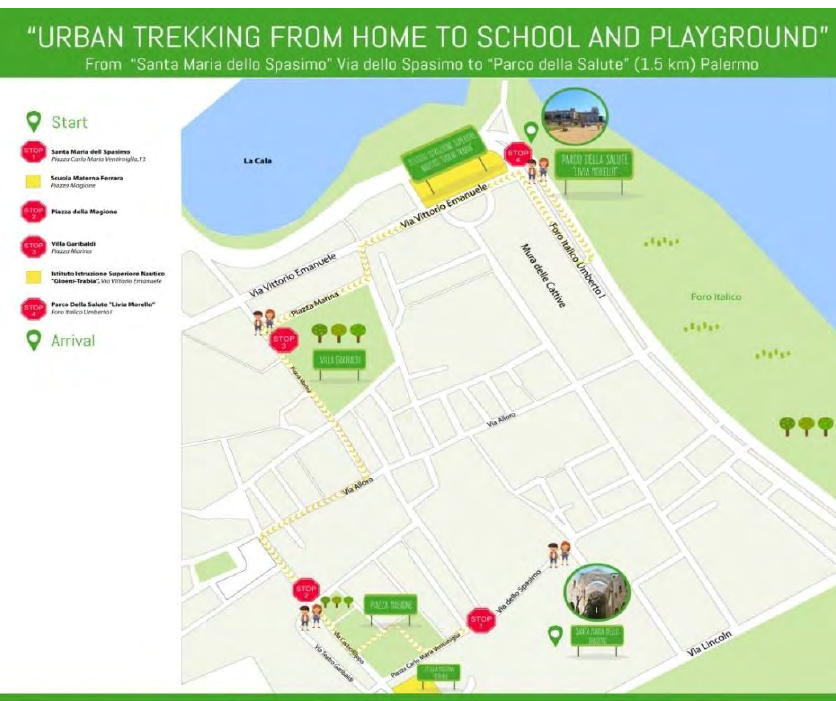
Figure 2 – Palermo’s urban trekking route “ from home to